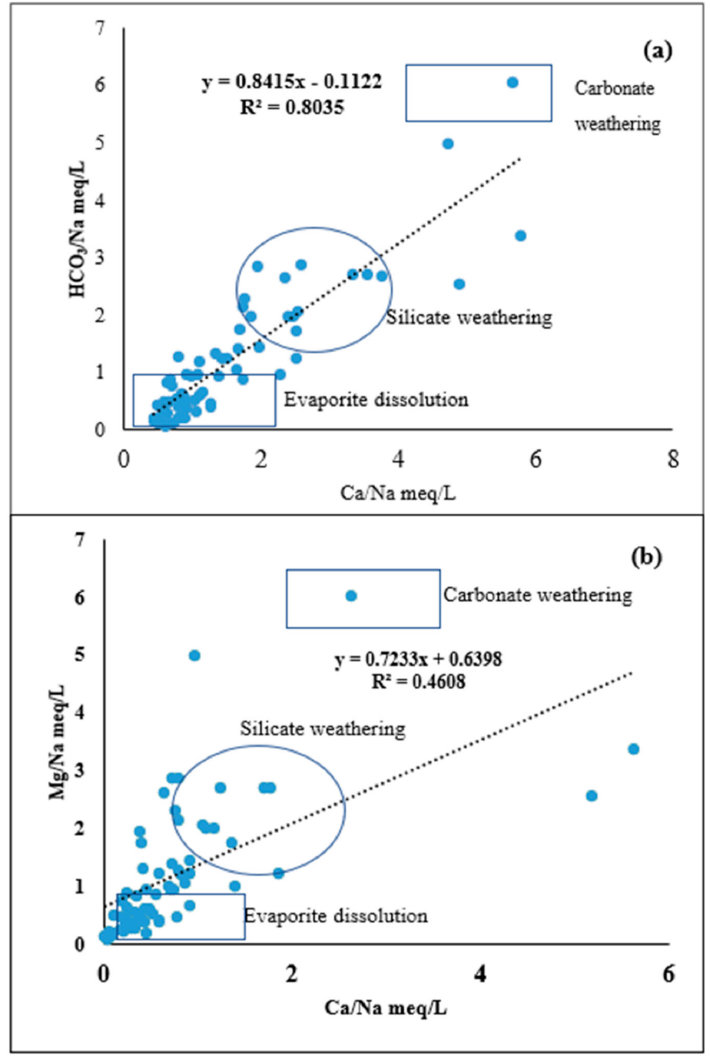
Figure 4. ( a ) Relationship of HCO 3 /Na versus Ca/Na. ( b ) Mg/Na versus Ca/Na to indicate evaporite mineral dissolution, carbonate, and silicate